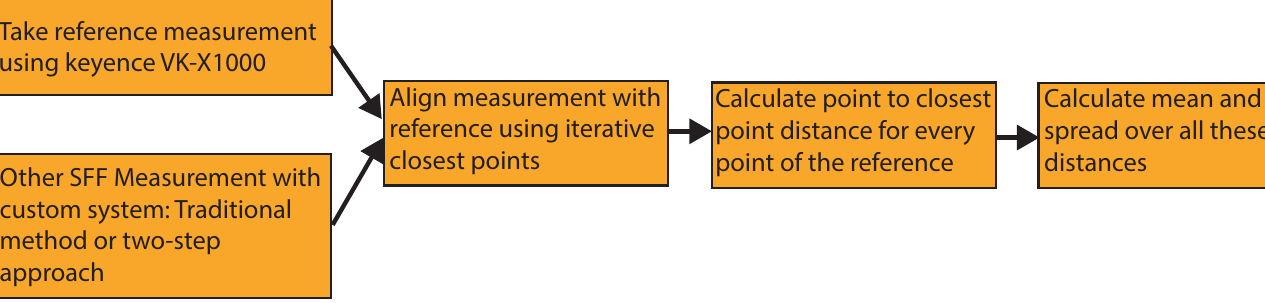
Figure 9. Comparison process of measurements of our own system with the reference measurements from the Keyence VK-X1000 with the CloudCompare software.